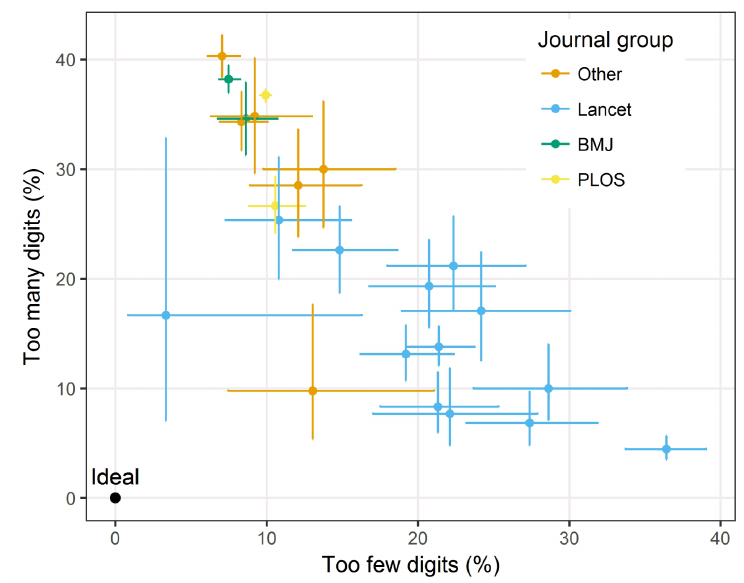
Figure 3. Scatter plot of the percent of times journals used too few and too many decimal places with 95% confidence intervals (horizontal and vertical lines).